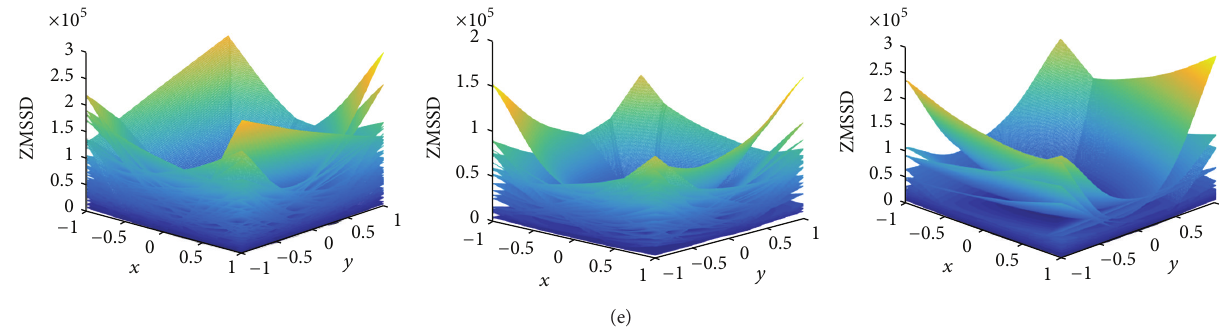
Figure 4: The ZMSSDs for rotation and translation of features: (a) shows the images for feature detection; (b), (c), and (d) are the ZMSSDs with rotations around 𝑥 -axis, 𝑦 -axis, and 𝑧 -axis; (d) illustrates the ZMSSDs with the translations along 𝑥 -axis and 𝑦 -axis.